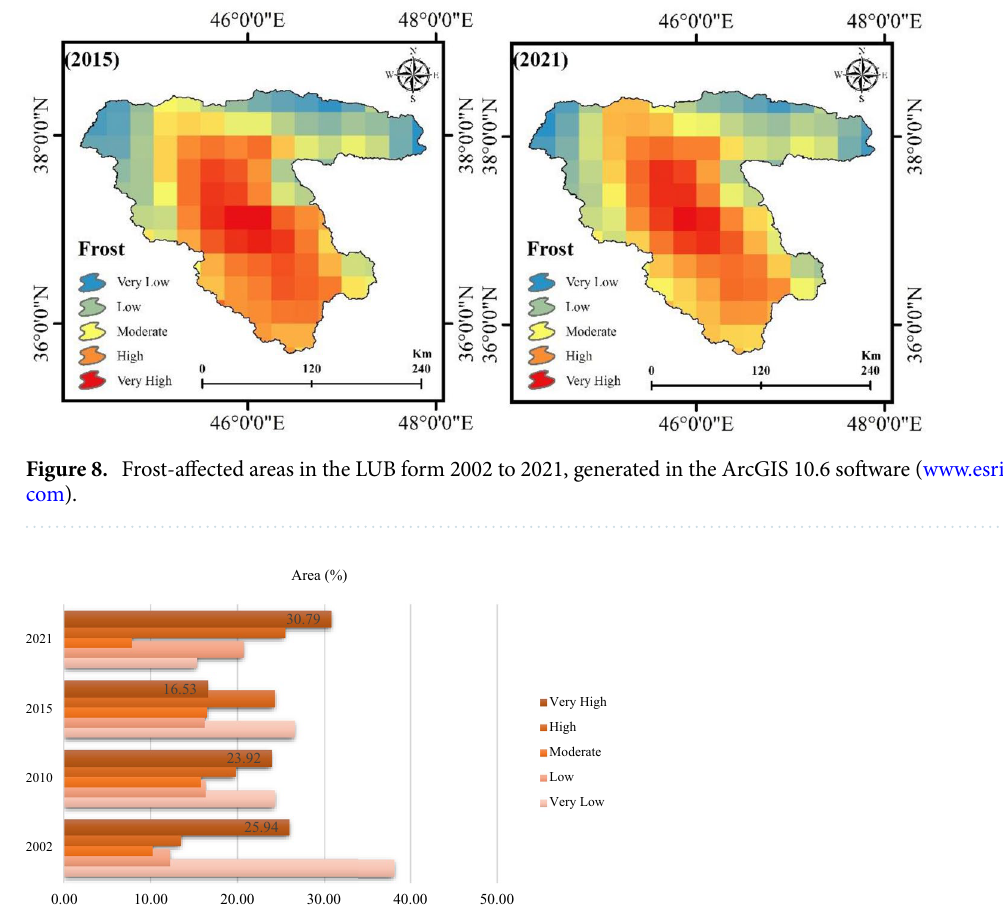
Figure 9. Frost-affected areas variation (%) within the LUB form 2002 to 2021, generated in Microsoft Excel 2022 software (www. micro soft.